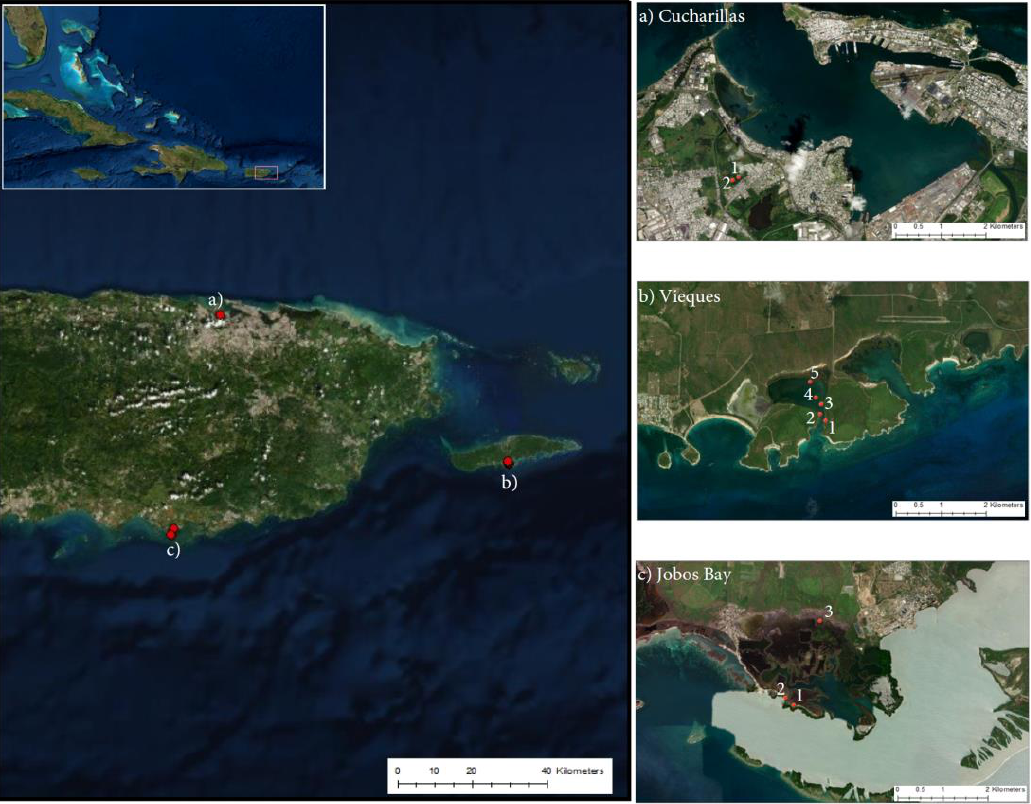
Figure 7. Sample sites at ( a ) Cucharillas, Cataño, ( b ) Puerto Mosquito, Vieques, and ( c ) Jobos Bay National Estuarine Research Reserve. Each sample site at each location is numbered with the lowest number closest to open, saltwater water and the largest number farthest from the marine source.